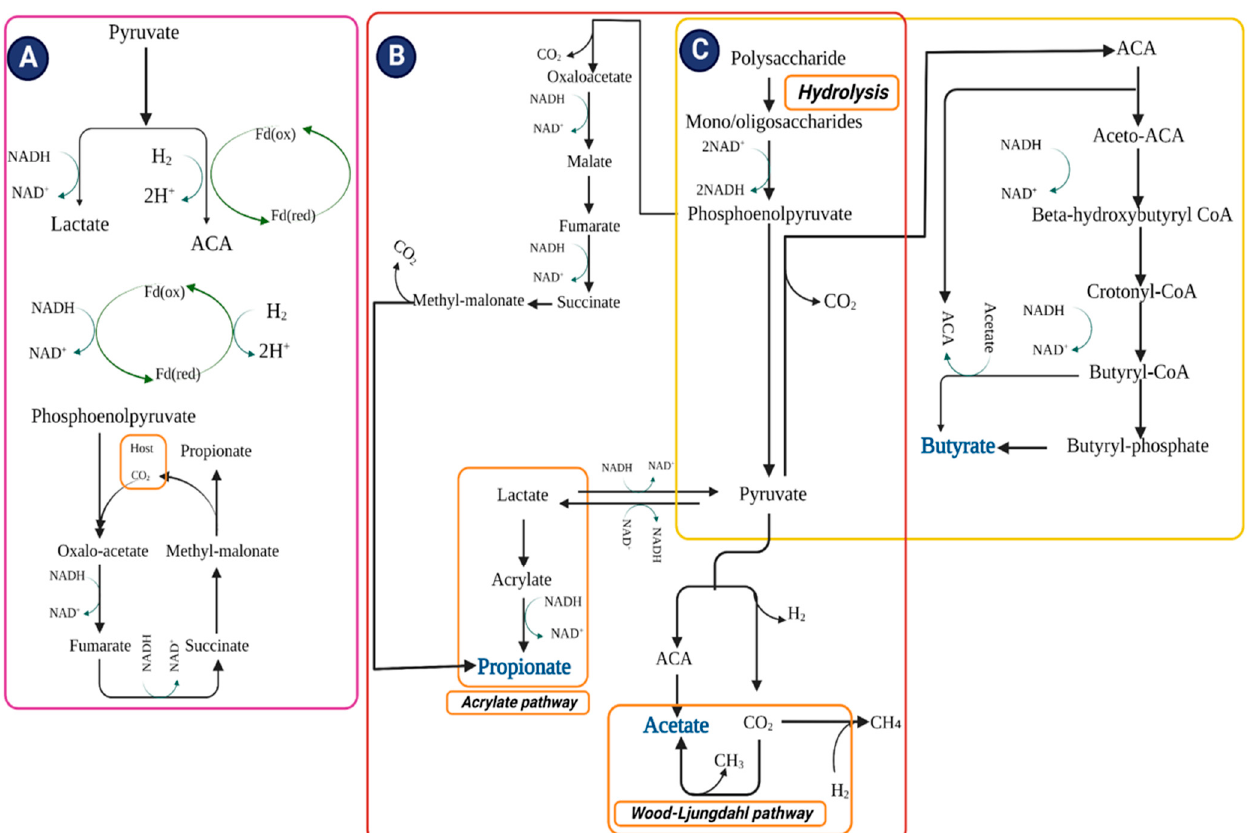
Figure 2. Schematic presentation of three pathways that contribute to disposing of excess reducing equivalents. ( A ) Reduction of pyruvate into lactate, thereby reducing NADH, pyruvate; ferredoxin oxidoreductase and hydrogenase/NADH; ferredoxin oxidoreductase and hydrogenase dispose of reducing equivalents into molecular hydrogen and NADH is reduced via electron transport chain. ( B ) Acetate is formed directly from acetyl CoA through the Wood–Ljungdahl pathway. Propionate is formed from PEP via succinate decarboxylation pathway or acrylate pathway while reducing propionate. ( C ) Butyrate is shaped by condensing acetyl CoA (two molecules) in the presence of butyrate kinase or by employing exogenously derived acetate through butyryl-CoA: acetate-CoA transferase. Abbreviations: NADH; nicotinamide adenine dinucleotide (NAD) + hydrogen (H): ACA; acetyl coenzyme A: H; Hydrogen: CO 2 ; carbon dioxide: CH 3 ; methyl radical: CH 4 ;